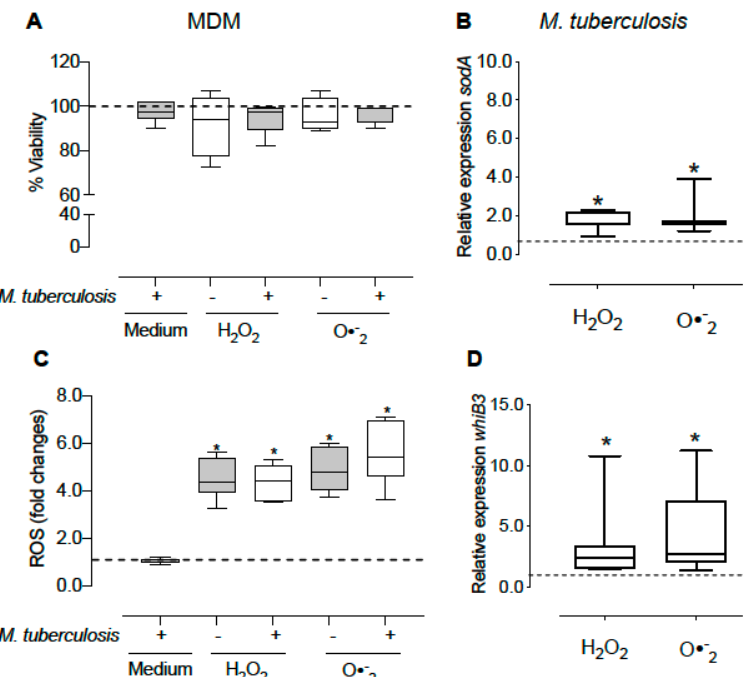
Figure 3. Effect of oxidizing agents on whiB3 and sodA gene expression of intracellular mycobacteria. The MDM were treated with 5 mM H 2 O 2 and O 2• − generator system for 15 min, and then infected with M. tuberculosis H37Ra (MOI 1:15) in the presence of these oxidants for 1 h. Non-phagocytized bacteria were removed, and fresh medium plus oxidants was added for 2 h. We detected cell viability ( A ) and ROS levels ( C ) in macrophages. Furthermore, the RNA expression levels of whiB3 and sodA ( B , D ) were determined in intracellular bacteria. The data show the maximums and minimums by quartiles. * p < 0.05 significant difference compared to the expression of uninfected macrophages ( A , C ) or intracellular bacteria without treatment ( B , D ), n = 4–8. The Wilcoxon test was used to compare to the control. In panels A and C, the dashed horizontal line represents the median of the uninfected macrophages without treatment, and in panels ( B , C ), it represents the median of the intracellular bacteria without treatment.